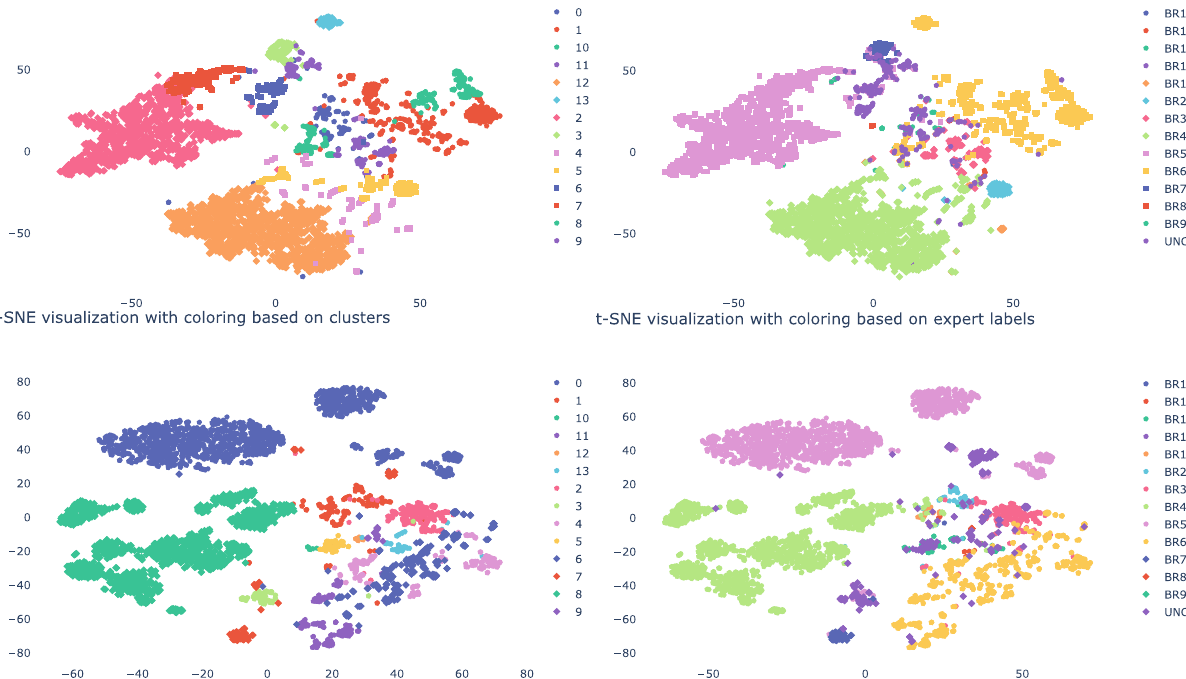
Figure 3. The t-sne visualization for company A obtained with finWalk (top) and DeepWalk (bottom), with on the left the clusters as indicated by the agglomerative clustering algorithm and on the right the expert’s labels.